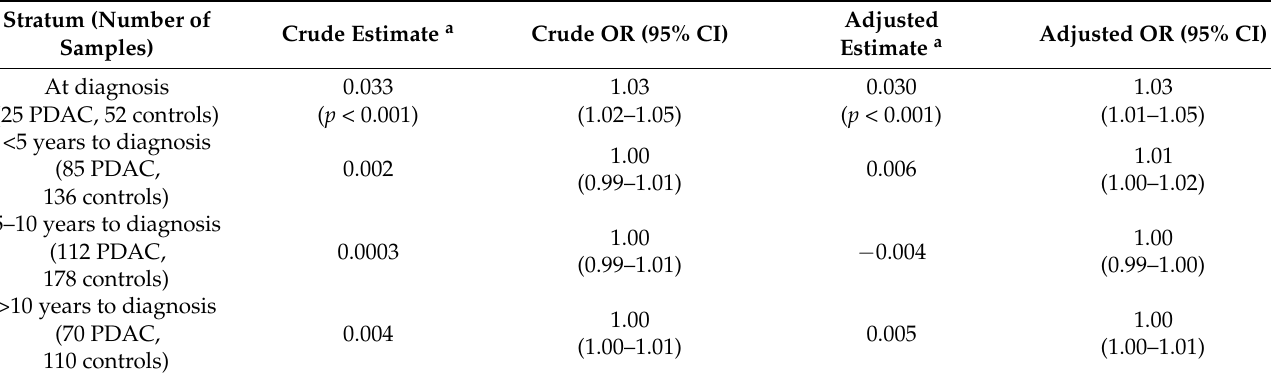
Figure 1. Flowchart of included and excluded samples in the ( A ) pre-diagnostic cohort and ( B ) diagnostic cohort. NSHDS = Northern Sweden Health and Disease Study. Table 3. Estimates and odds ratios for TPS adjusted for